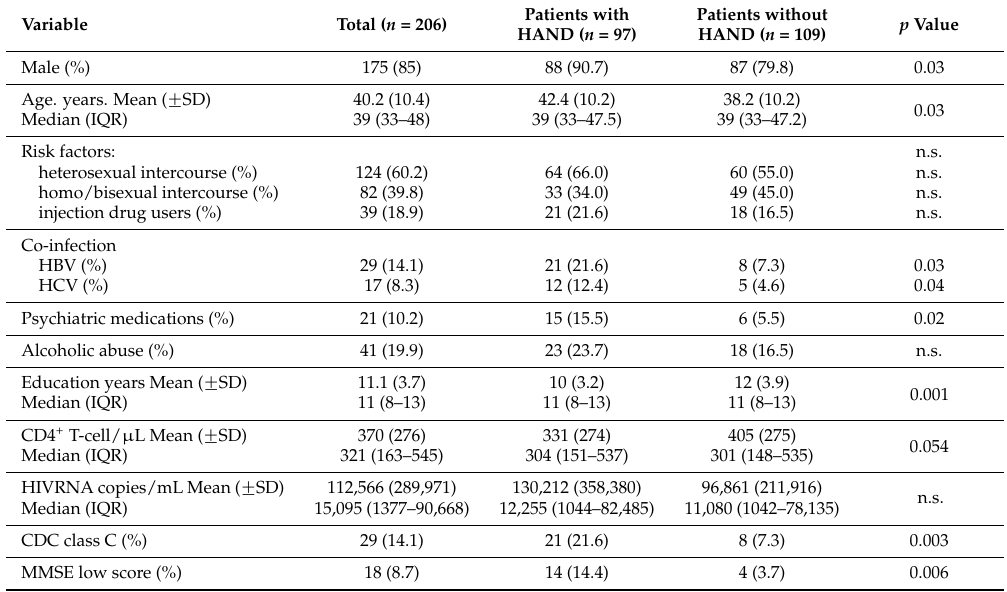
Table 1. Demographic, clinical and neuropsychological characteristics of patients at the